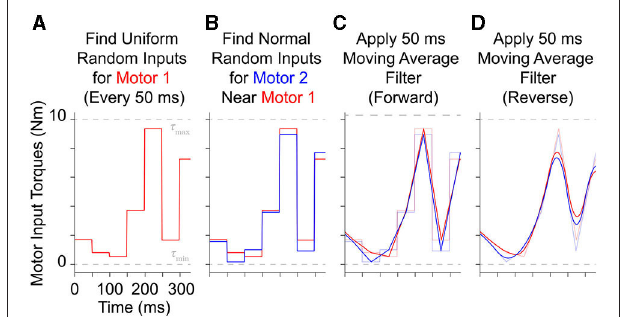
FIGURE 3 | Example of how 300 ms of motor babbling signals are generated. (A) Random motor torque inputs are uniformly sampled from the range of possible inputs and assigned to 50 ms windows for motor 1 ( red ). (B) Then values for motor 2 ( blue ) are selected for each window from a normal distribution centered around the values for motor 1 with a standard deviation of 0.5 Nm (5% of the range of maximum input level). These discontinuous, piece-wise signals are then filtered using a forward (C) and backward (D) finite impulse response moving average filter with a filter lengths of 50 ms. This results in correlated band-limited, low frequency ( ≤ 10 Hz) white noise motor babbling